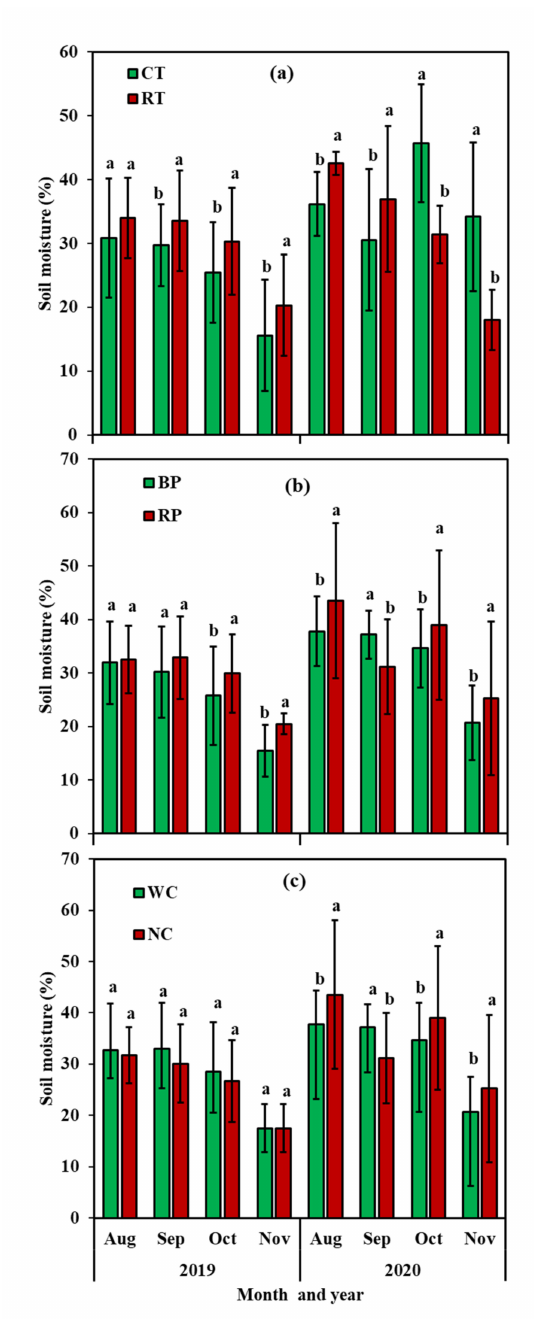
Figure 4. Average monthly soil moisture under different tillage ( a ), sowing ( b ), and soil compaction ( c ) practices in 2019 and 2020. RT, reduced tillage; CT, conventional tillage; RP, row planting; BP, broadcast planting; WC, soil compacted; NC, soil not compacted. In each month, bars labeled with different letters significantly differed at p < 0.05. Soil moisture data for 2018 were not recorded as the moisture sensor was not functional in